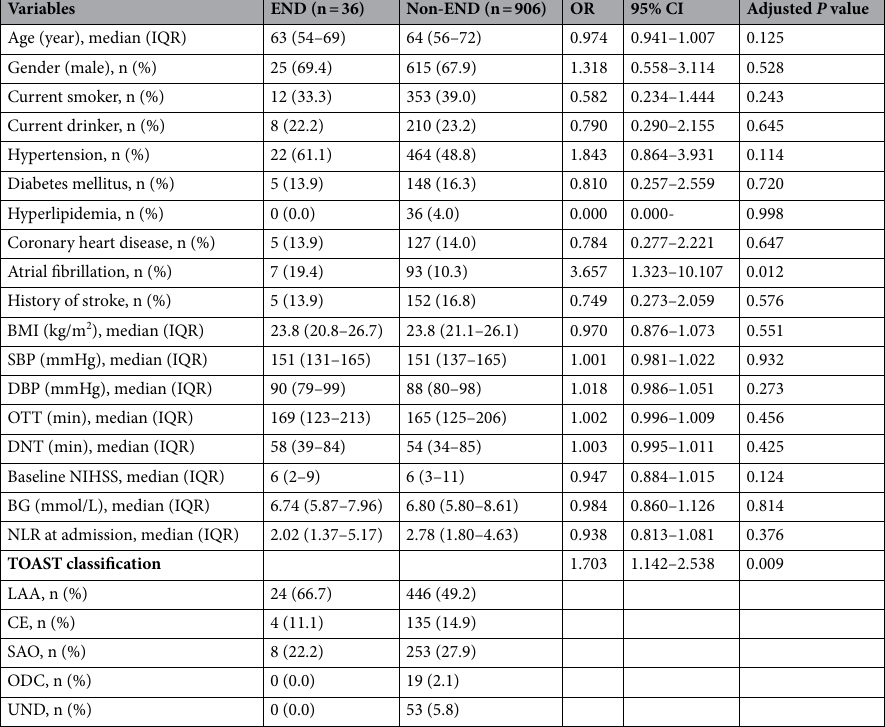
Table 2. Multivariate logistic regression analysis on associated factors in ACS group. ACS anterior circulation stroke, BG blood glucose, BMI body mass index, CE cardioembolism, DBP diastolic blood pressure, DNT door to needle time, END early neurological deterioration, IQR interquartile range, LAA large-artery atherosclerosis, NIHSS National Institute of Health Stroke Scale, NLR neutrophil-to-lymphocyte ratio, ODC stroke of other determined cause, OTT symptom onset to thrombolysis time, SAO small-artery occlusion, SBP systolic blood pressure, TOAST trial of Org 10,172 in acute stroke treatment, UND stroke of undetermined